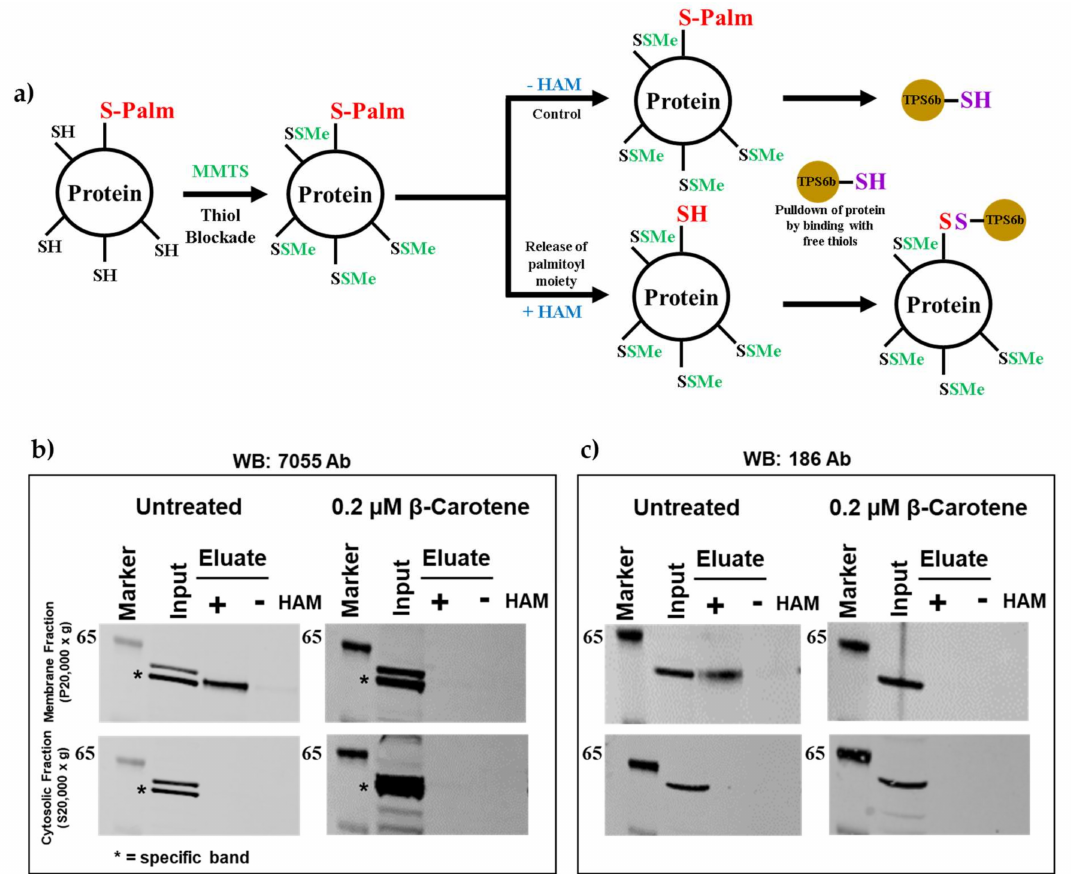
Figure 1. Detection of mBCO2 palmitoylation by acyl-RAC assay. ( a ) A schematic overview of the acyl-RAC method to detect the protein palmitoylation. Analysis of palmitoylation of mBCO2 from HEK293F-expressed lysates treated with 0.2 µ M β -carotene in 0.01% OTG or 0.01% OTG vehicle control was performed by acyl-RAC assays. Samples were treated with a final concentration of 0.25M hydroxylamine (HAM) or 0.25M NaCl (control) and palmitoylated proteins were then enriched using beads (thiopropyl-sepharose 6b; TPS6b for acyl-RAC) and were eluted using 2.5% β -mercaptoethanol (BME) in SDS-PAGE sample bu ff er. Equal amounts (~20 µ g) of total (indicated as “input”) and eluted protein from control (indicated as “ − ”) and HAM-treated (indicated as “ + ”) samples were separated by SDS-PAGE, followed by immunoblotting with primary rabbit polyclonal antibody to BCO2 ( b ) Analysis of palmitoylation of untagged mBCO2 from HEK293F-expressed lysates treated with β -carotene or vehicle control was performed by acyl-RAC assays. The presence of mBCO2 was probed by immunoblotting with rabbit polyclonal anti-human BCO2 (7055). Results are representative of three independent experiments. ( c ) Analysis of palmitoylation of untagged mBCO2 from HEK293F-expressed lysates treated with β -carotene or vehicle control was performed by acyl-RAC assays. The presence of mBCO2 was probed by immunoblotting with rabbit polyclonal anti-mouse BCO2 (186). Second, we cloned mBCO2 cDNA into pcDNA6.2c-Lumio-DEST cloning vector with